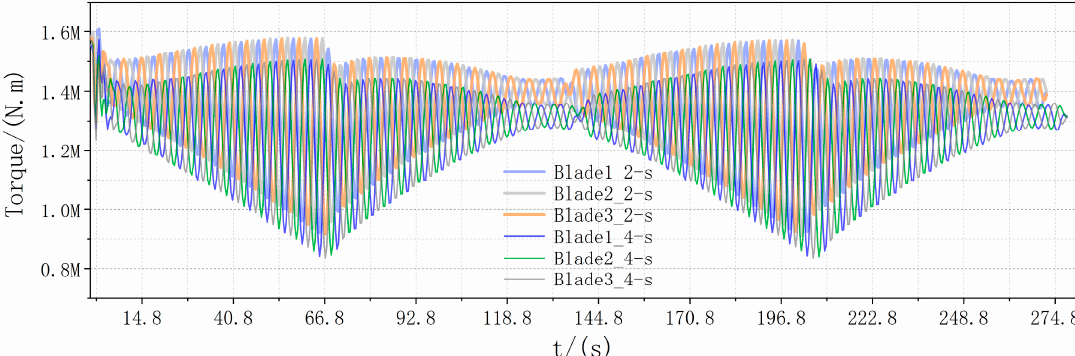
Energies 2019 , 12 , x FOR PEER REVIEW Figure 17. Torque characteristics of blades under two different yaw velocities. Figure 17. Torque characteristics of blades under two different yaw velocities. Figure 17. Torque characteristics of blades under two di ff erent yaw velocities.